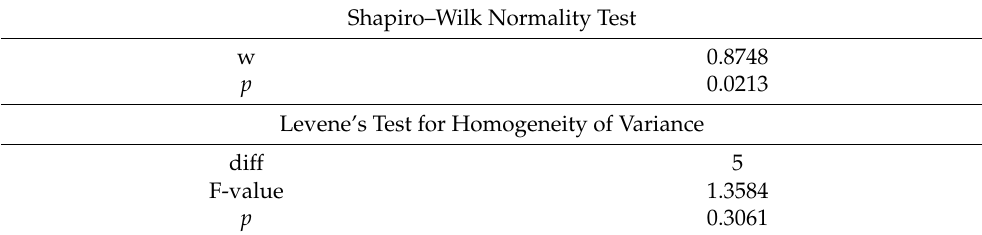
Table 9. Summary of factor importance and Tukey HSD results (JIS).